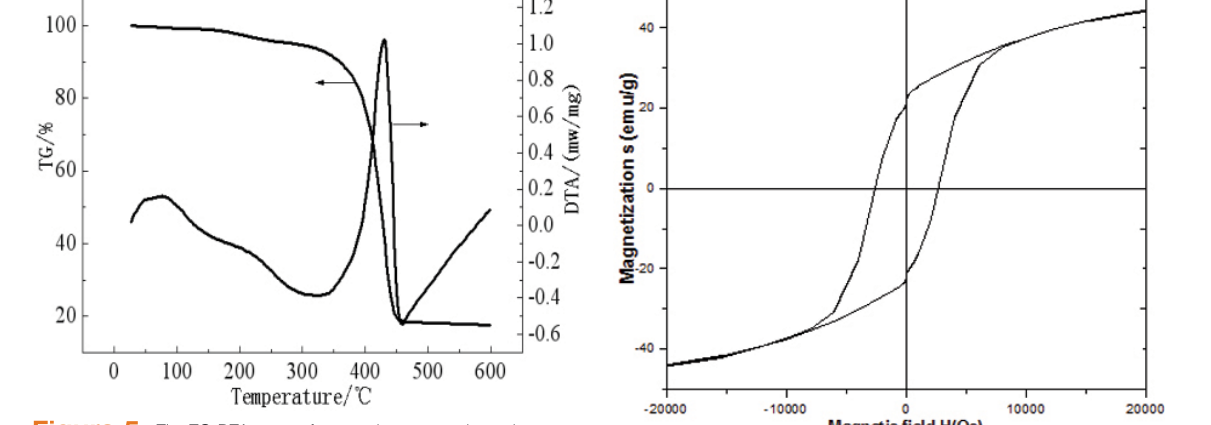
Figure 5. The TG-DTA curve of magnetic porous microspheres.